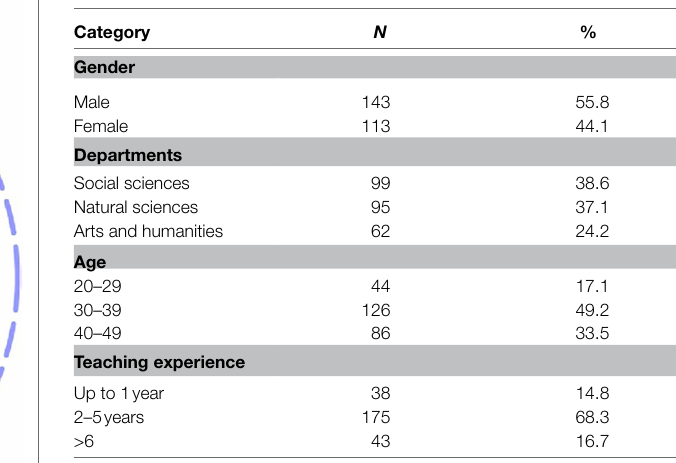
TABLE 1 | Demographic statistics of the respondents.